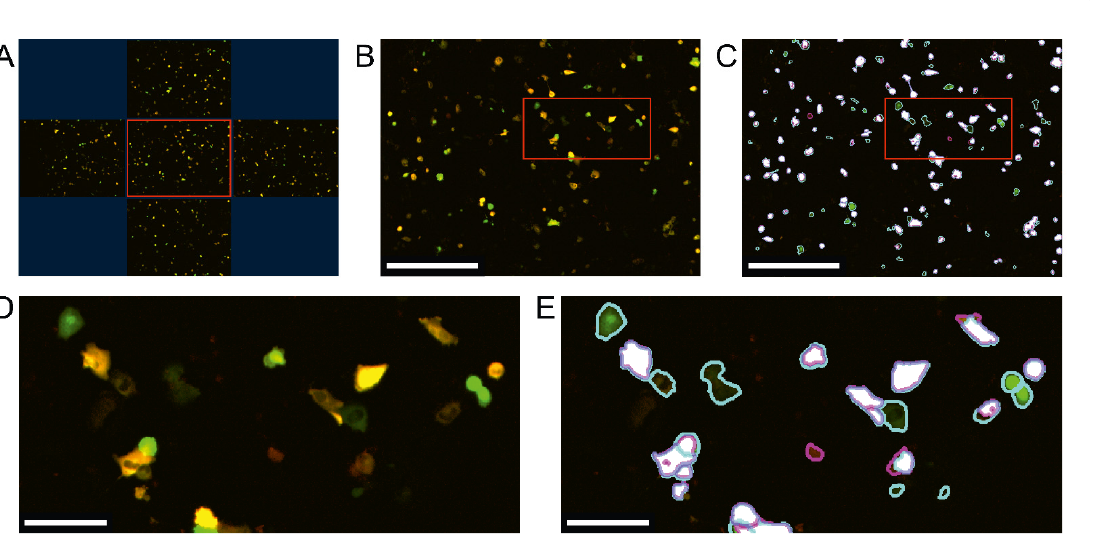
Figure 5. High throughput fluorescence microscopy workflow of C28/I2 human chondrocyte cell line transfected with CaMPARI2 ‐ F391W. ( A ) The IncuCyte S3 high ‐ throughput microscope of Sartorius took five images per well of 96 ‐ well plates. The shown cells were treated with 100 μ M histamine directly after the parabolic flight and were illuminated for 8 s by photoconversion light 15 s after the histamine stimulus. The centered image (red frame in A ) was used as an example to show the mask created with the IncuCyte 2021A software in B and D . ( B , D ) Green and Red fluorescence of CaMPARI2 ‐ F391W is depicted as an orange merge. The red frame is the image section displayed in C and E. ( C , E ) Cells only identified as green fluorescent are circled cyan. Cells only identified as red fluorescent are circled purple. Cells identified by the IncuCyte mask as green and red fluorescent are colored white. The scales in ( B ) and ( C ) represent 500 μ m; the scales in ( D , E ) represent 100 μ m.